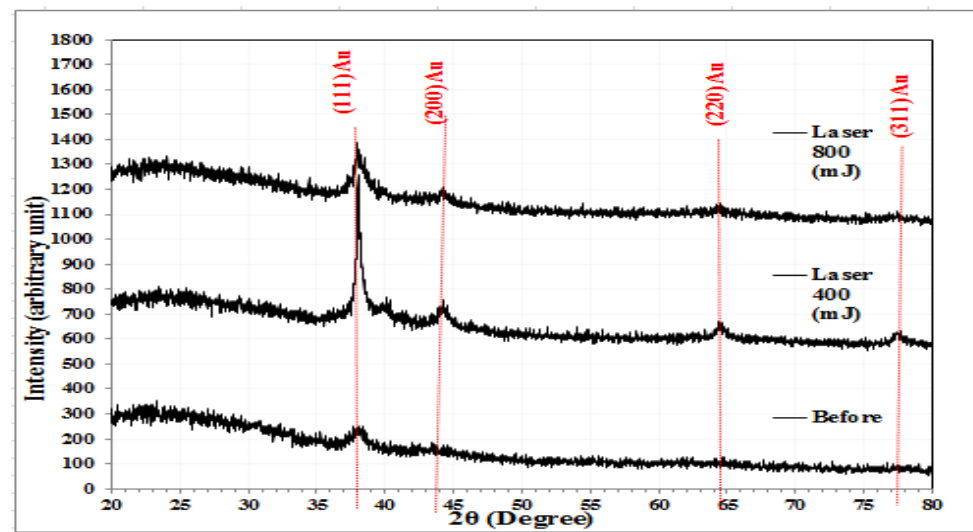
Fig. 12: X-ray diffraction pattern of C-alloy colloid NPs for exploding currents 100A and synthesized by (400 m J, 800 m J) laser energies Irradiation.